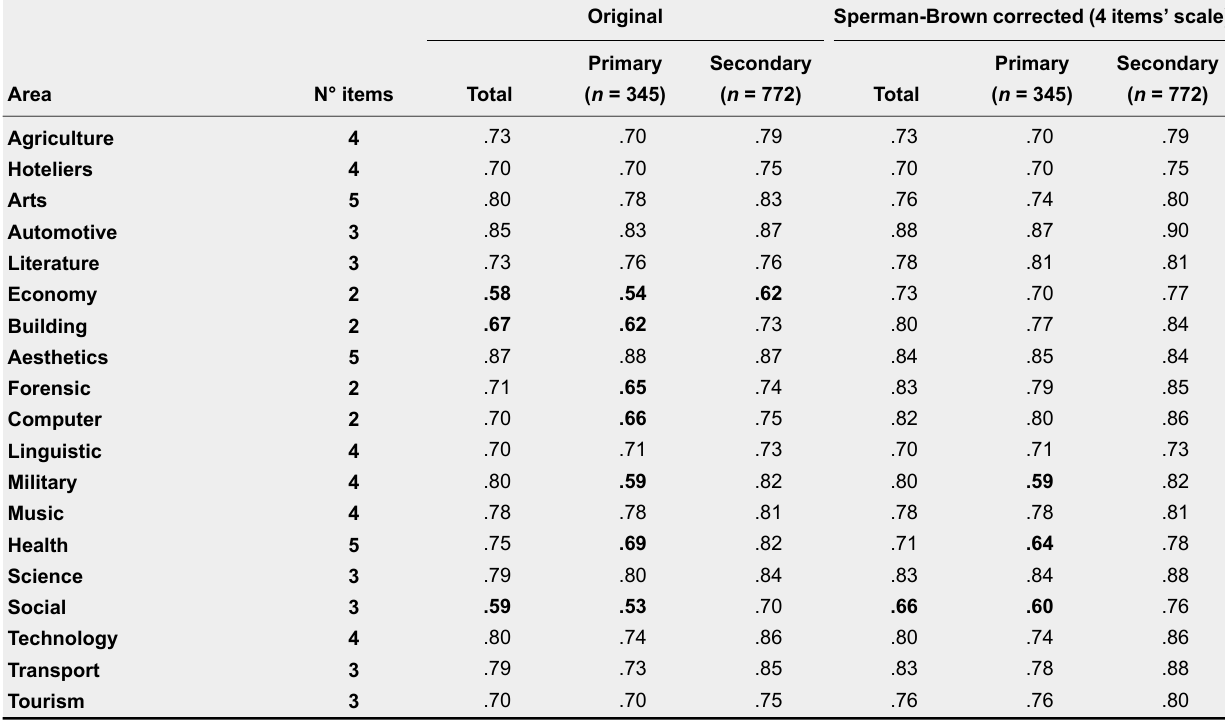
Internal Consistency: Cronbach’s α Index